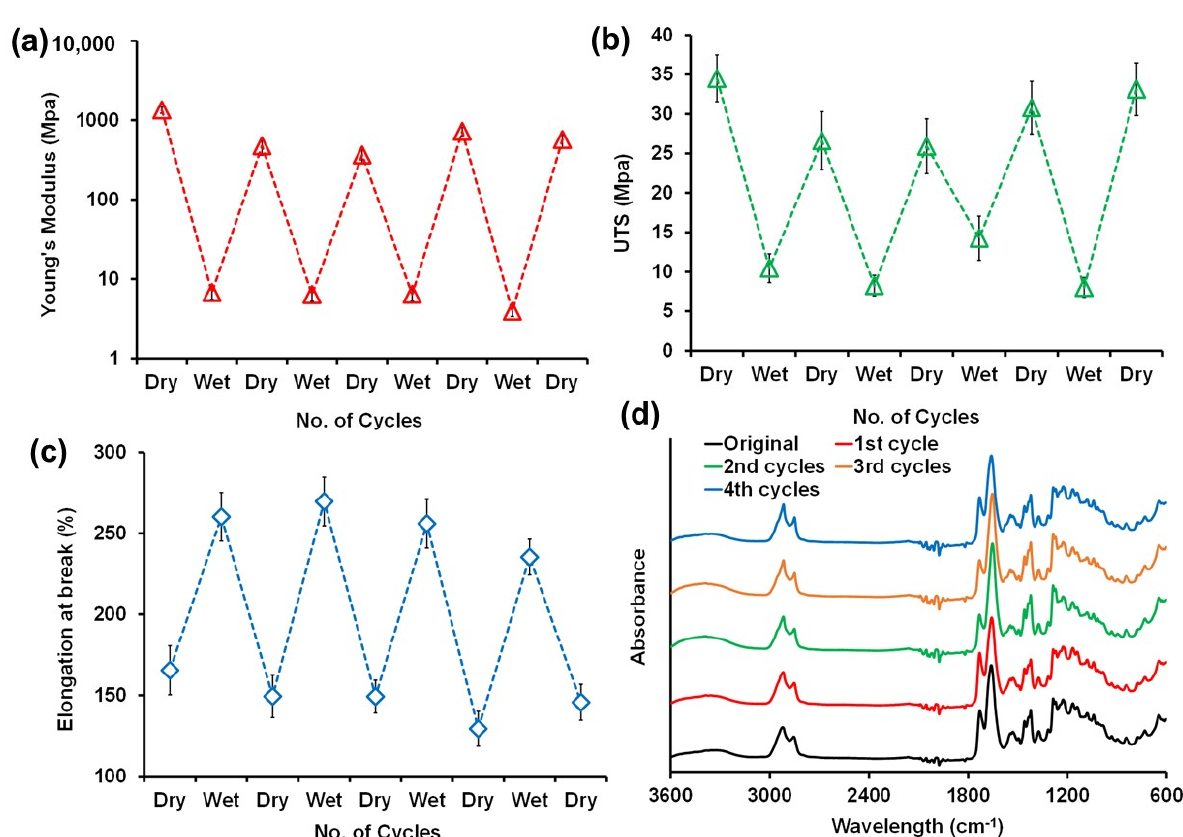
Figure 8. Mechanical properties of PU/PVP_50/50 film in response to wet–dry cycles. ( a ) Changes in elastic modulus, ( b ) changes in UTS, ( c ) changes in elongation at break values and ( d ) FTIR spectra after each wet–dry cycle indicating no chemical changes in the film due to cycling tests.